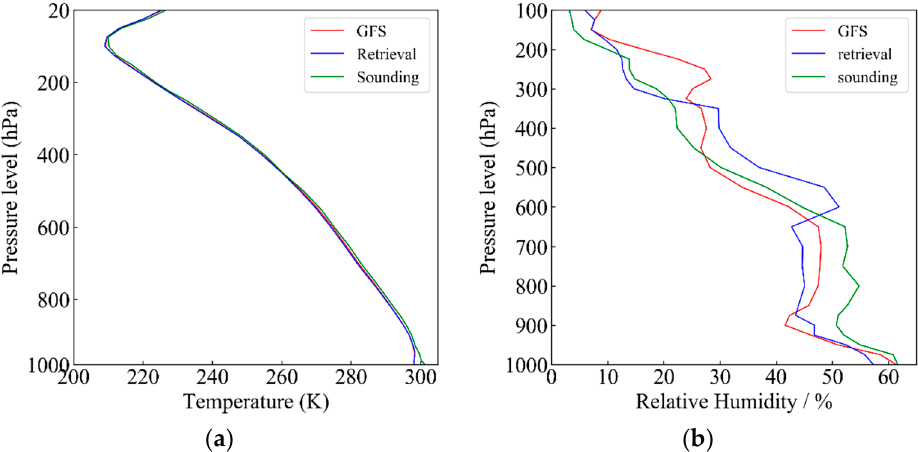
Figure 13. Comparison of retrieval results with sounding data (ground truth) and forecast data. ( a ) Temperature; ( b ) hu- midity.